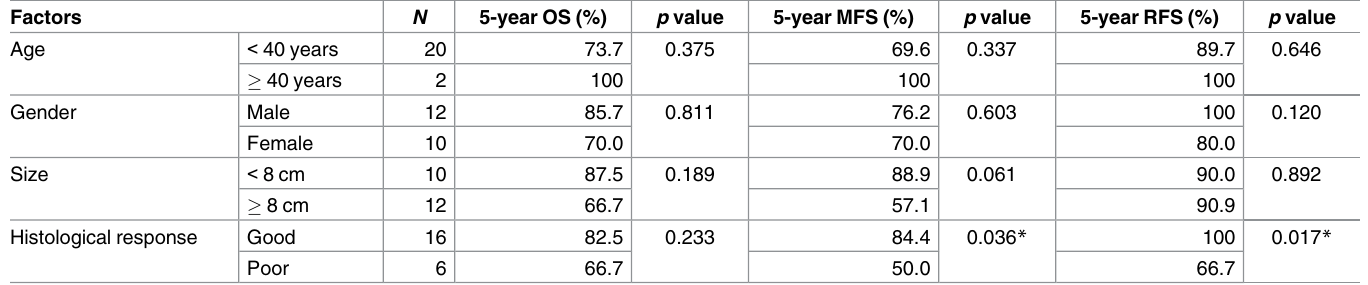
Table 3. Prognostic factor